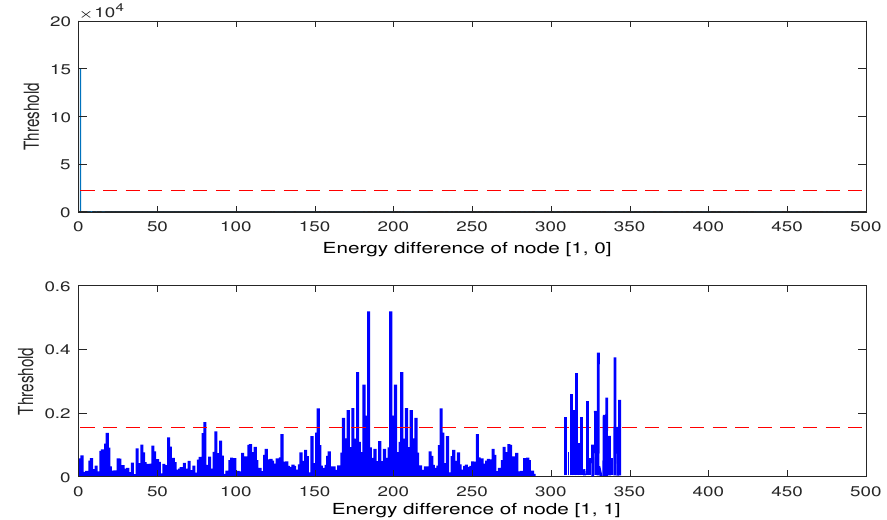
Figure 10. Energy difference result of first layer decomposition.